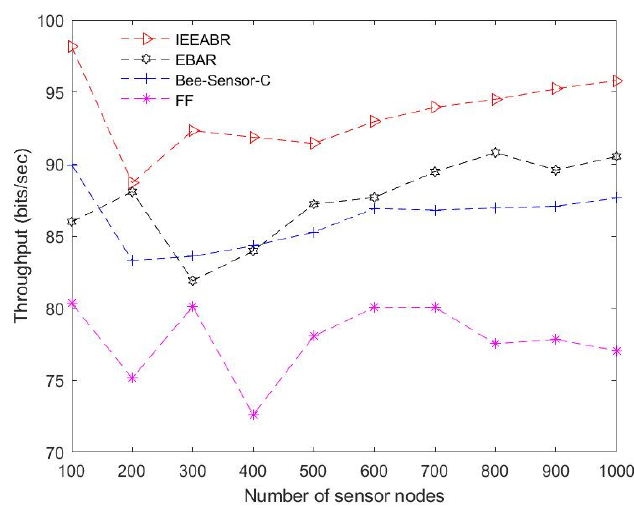
Figure 15. Comparison in terms of throughput.